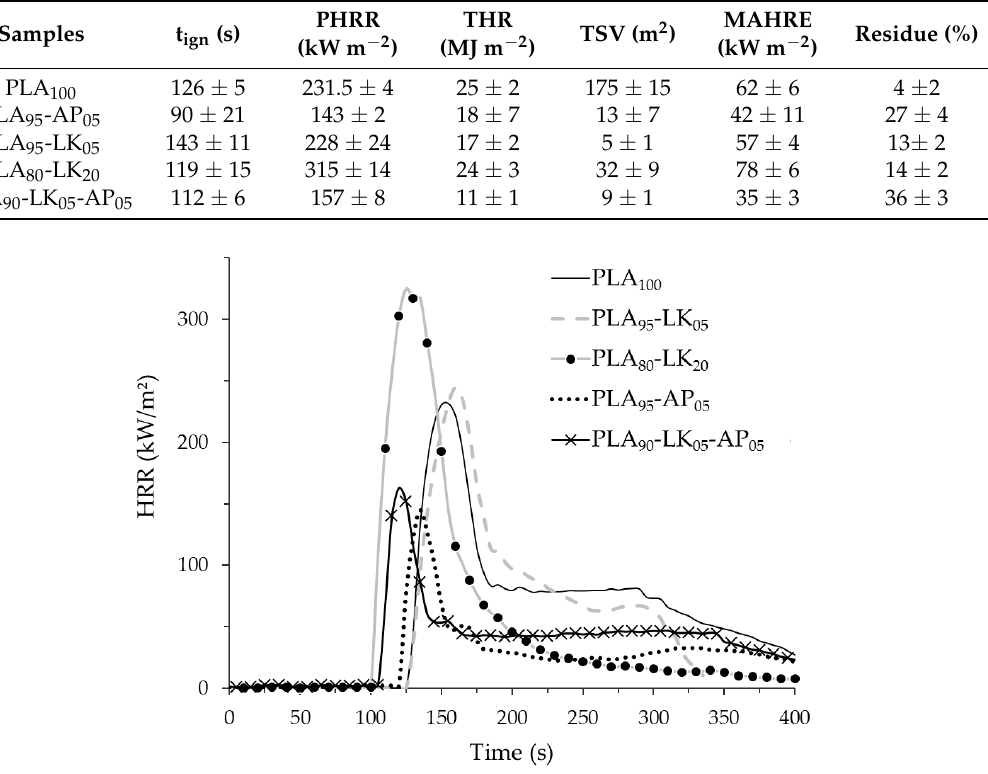
Figure 7. Heat release rate curves of the knitted fabrics (25 kW·m − 2 ).